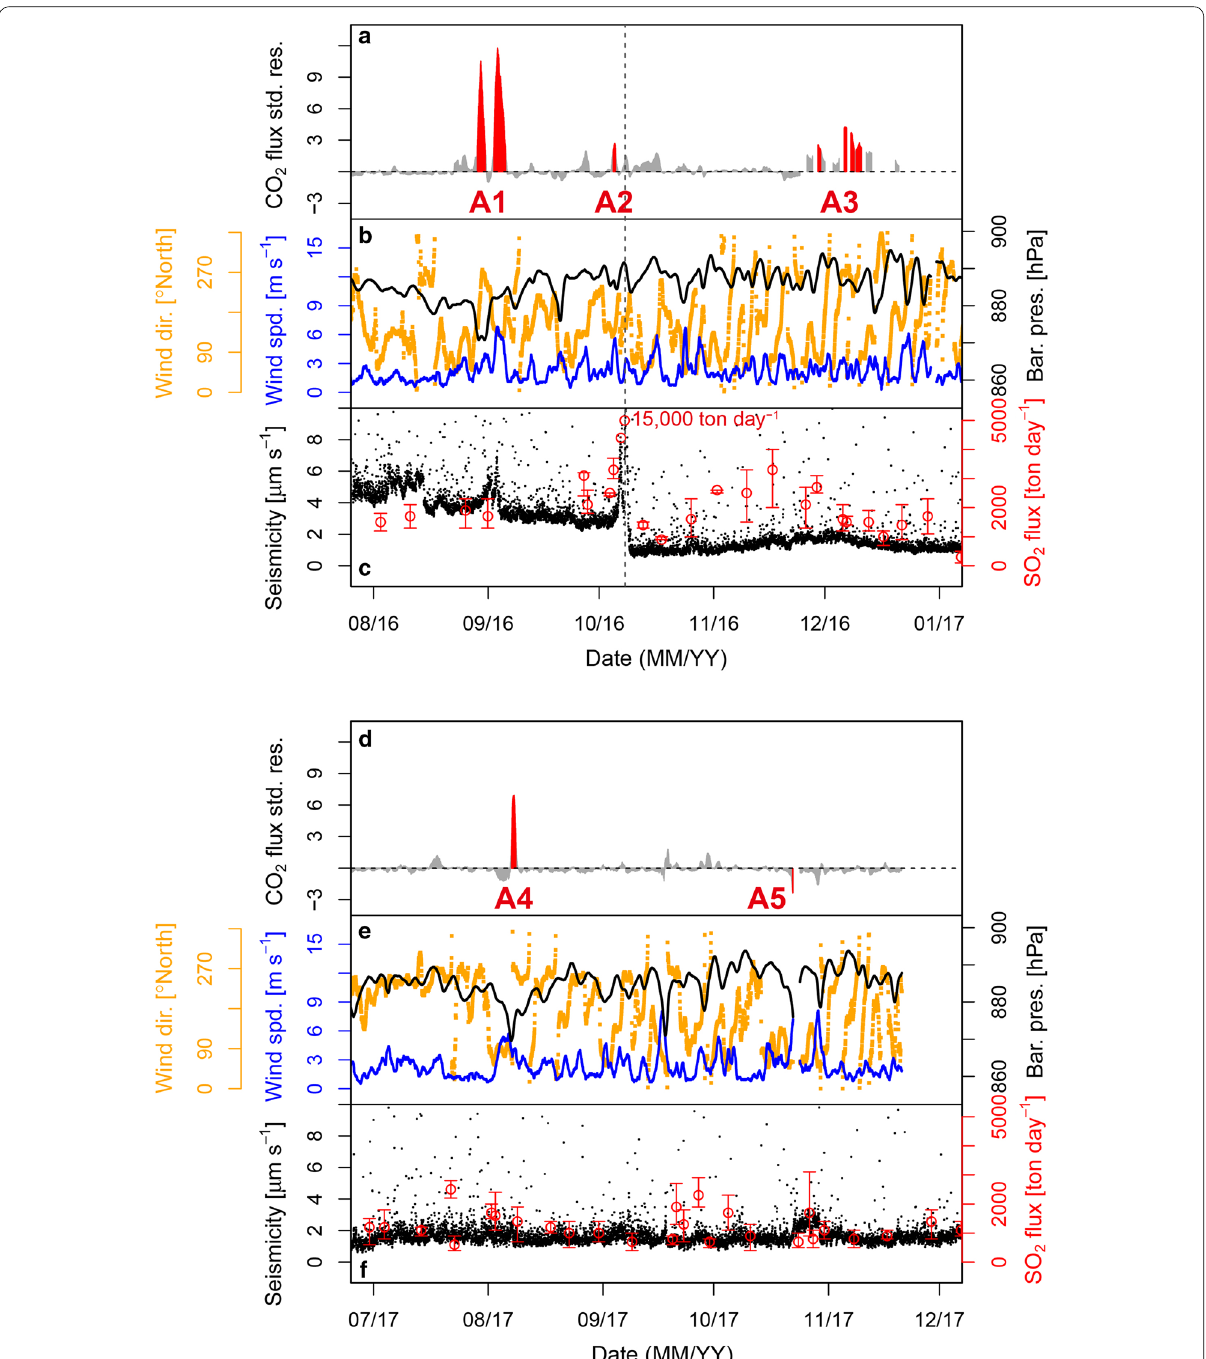
Fig. 10 Time series of a the standardized daily average for the residuals of soil CO 2 flux; b daily average for wind speed (blue line), wind direction (orange dot), and barometric pressure (black line); and c 30 min maximum seismic amplitude (black dot) and plume SO 2 flux (red circle) for the period including anomalies A1–A3. The colors in a are the same as those in Fig. 9a. The vertical dashed line in a – c corresponds to the timing of the 8 October 2016 eruption. The seismic amplitude is recorded at Sunasenri station of Kyoto University, which is 1.3 km S of the active crater, and is filtered at the frequency of 2 Hz. The plume SO 2 flux is from monthly reports by the Japan Meteorological Agency (available at http://www.data.jma. go.jp/svd/vois/data/tokyo /STOCK /month ly_v‑act_doc/month ly_vact_vol.php?id 503). d – f The same time series as a–c for the period including = anomalies A4 and